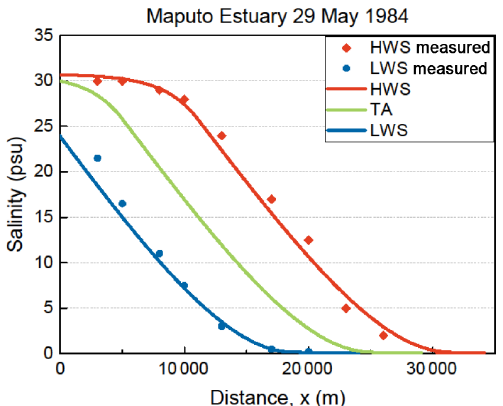
Figure 5. Application of the numerical solution to observations in the Limpopo Estuary for high water slack (HWS) and low water slack (LWS). The green line shows the tidal average (TA) condition. The red diamonds reflect the observations at HWS and the blue dots the observations at LWS on 10 August